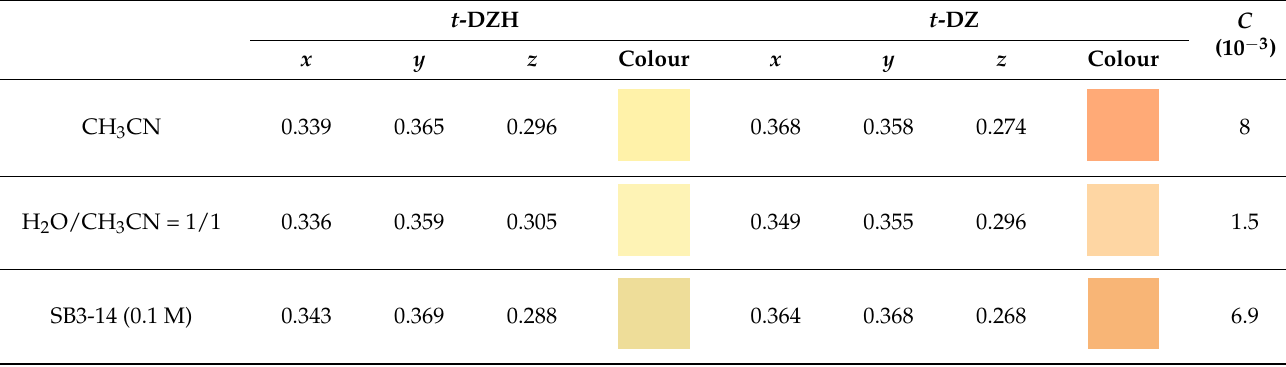
Table 2. Chromaticity coordinates and respective colours generated by t -DZH and t -DZ dissolved in the three media at the spectrophotometric concentrations of 5 × 10 − 5 M.